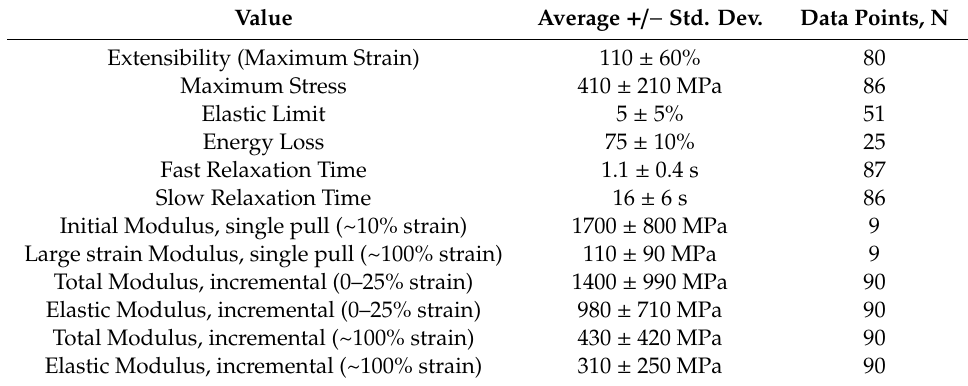
Table 1. Summary of the data collected in this paper. We followed the recommendation to use one decimal place more than the precision of our measurement [42]. We estimate the absolute error in our force measurement to be about 50% and in our extensibility measurement to be about 10%, given the error in the measured, experimental quantities. The high standard deviation of these values reflects the large variability across di ff erent fibers, not necessarily the error in measurements. Value Average +/ − Std. Dev. Data Points,